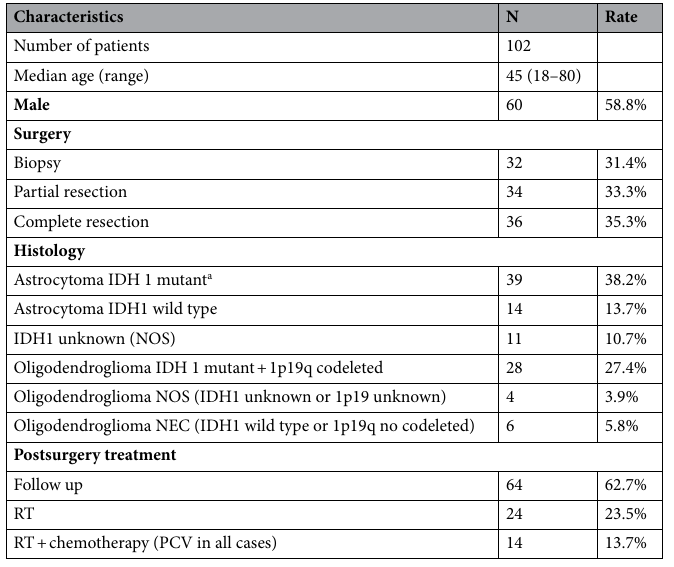
Table 2. Patient demographics. a R132H